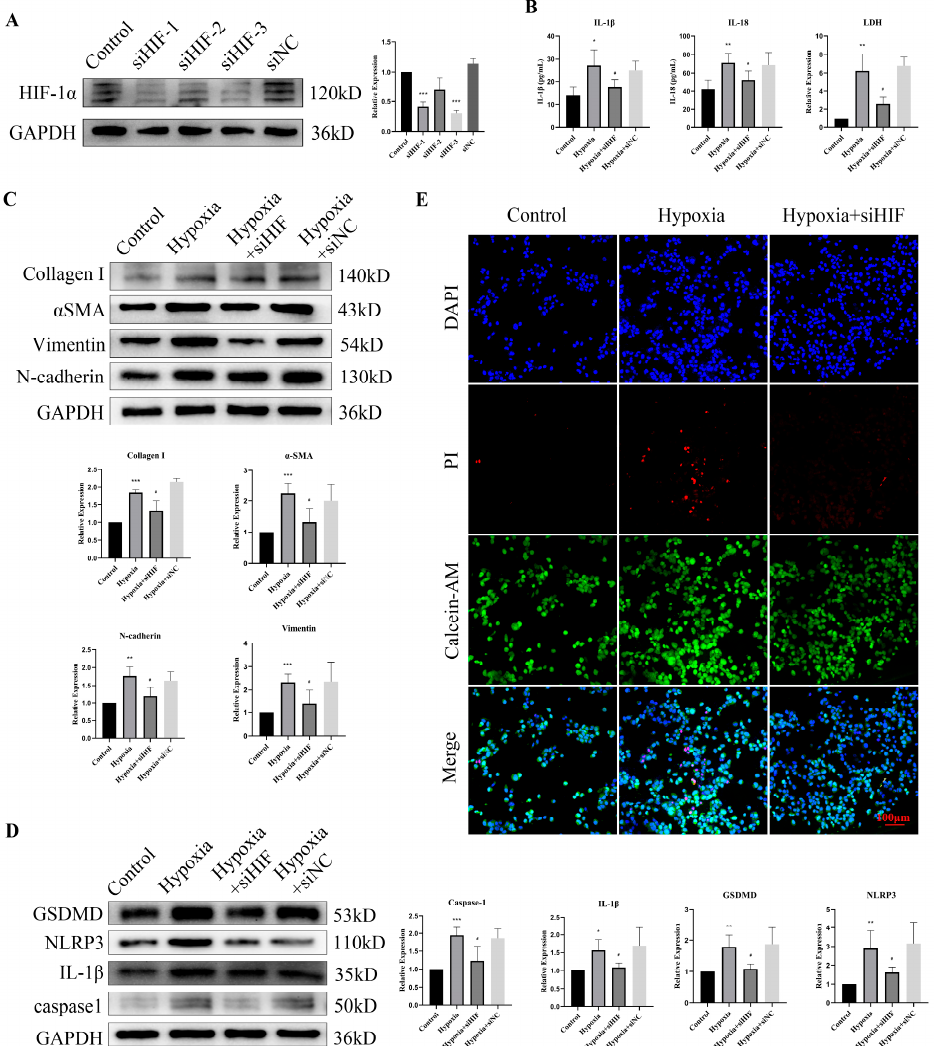
Figure 7. HIF-1 α knockdown rescued hypoxia-induced fibrosis through EMT and pyroptosis. ( A ) The knockdown efficiency of HIF-1 α in epithelial cells determined via Western blot. ( B ) HIF-1 α knock- down partially reversed the increased levels of IL-1 β , IL-18 and LDH in the supernatant after hypoxic exposure 12 h. ( C ) HIF-1 α knockdown partially reversed the upregulation of fibrosis- and EMT- related proteins in epithelial cells after hypoxic exposure for 12 h. ( D ) HIF-1 α knockdown partially reversed the upregulation of pyroptosis-related proteins in epithelial cells after hypoxic exposure for 12 h. ( E ) HIF-1 α knockdown ameliorated hypoxia-induced epithelial cell death. Data are presented as the mean ± S.D. (n ≥ 3). * p < 0.05; ** p < 0.01; *** p < 0.001. * p < 0.05 compared with the control group and # p < 0.05 compared with the hypoxia group. Scale bars, 100 µ